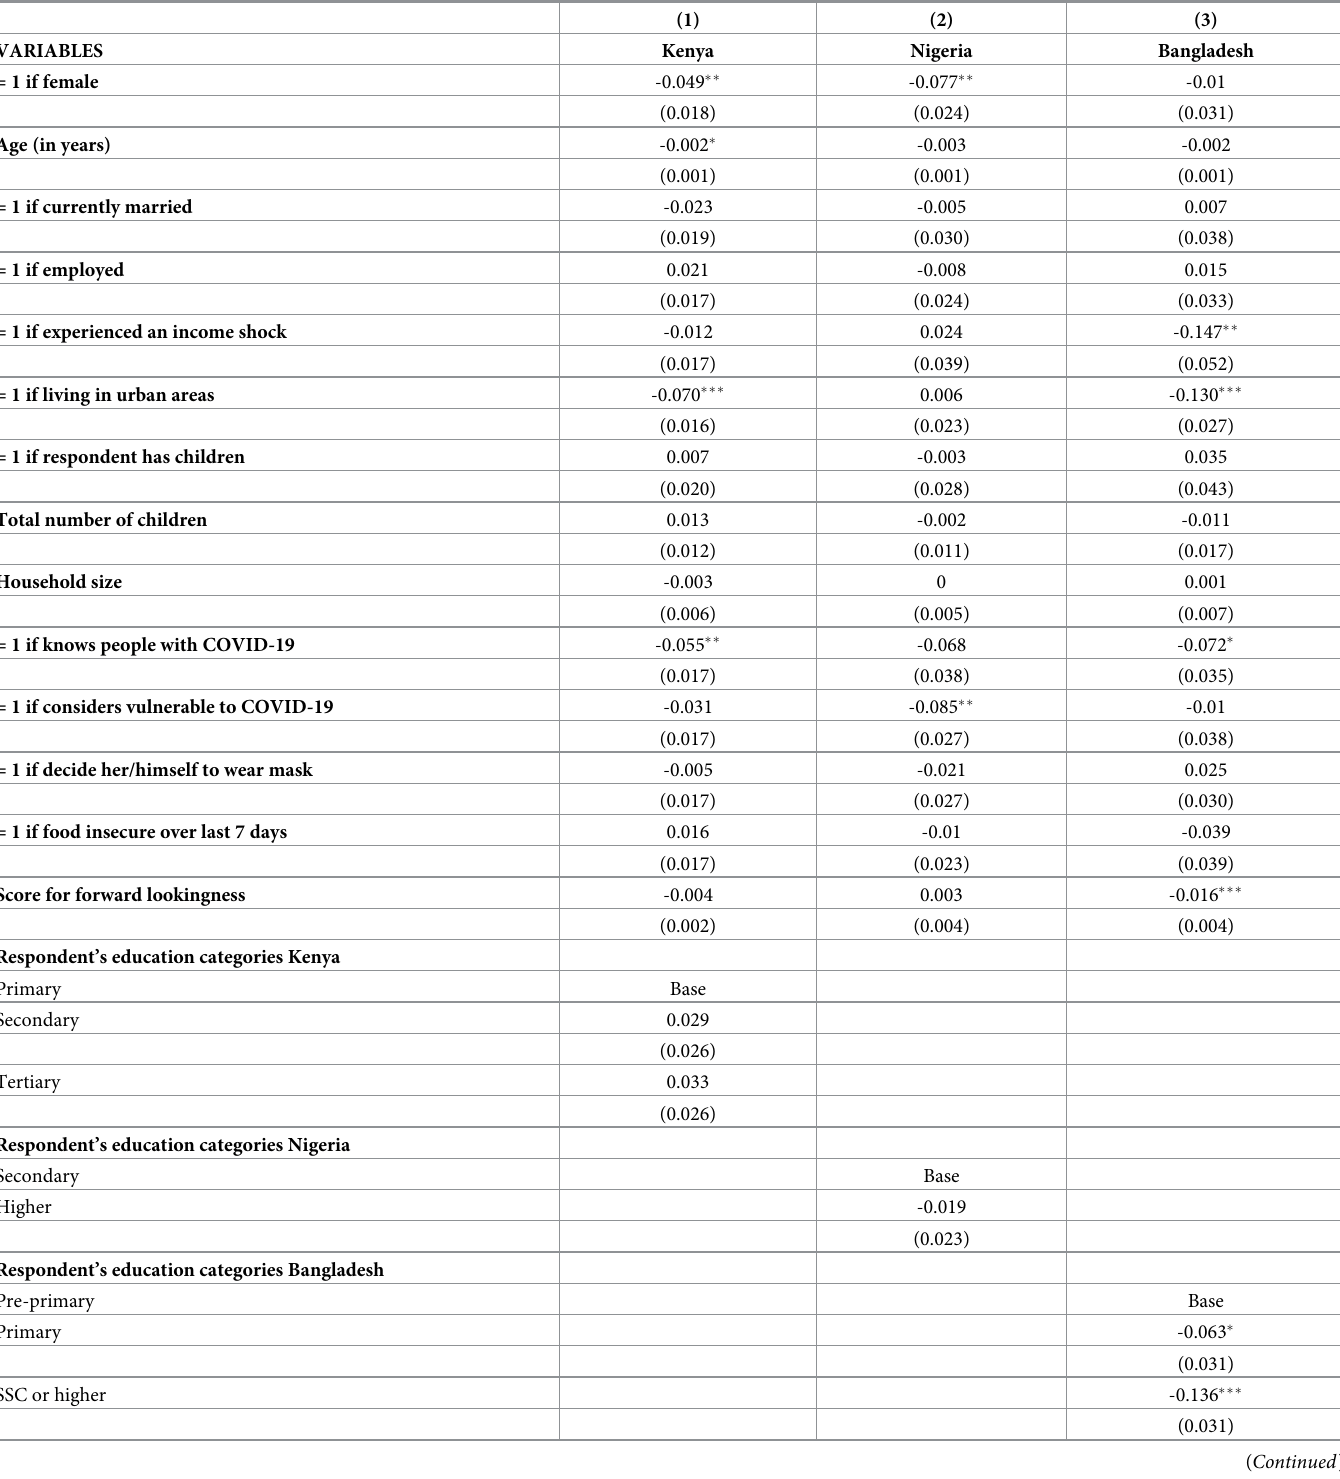
Table 3. Socioeconomic and demographic determinants of stated noncompliance with facemask wearing in all 3